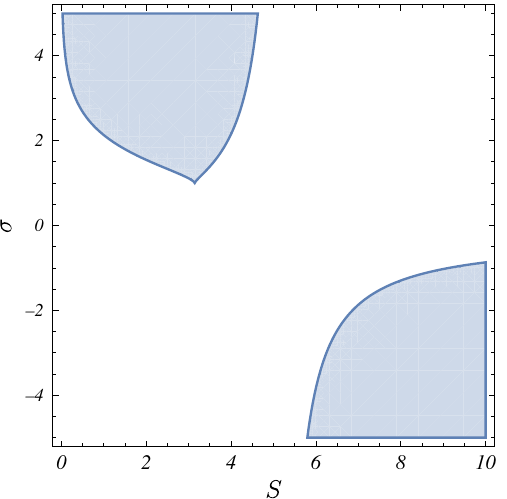
Fig. 2 Theregionsofpositivedefiniteinformationmetrictogetherwith C > 0 (the shaded regions) for the DST black hole with respect to the HPEM information metric. The upper region lies within 1 < σ < ∞ , while the lower region is defined within − ∞ < σ < − 1 /